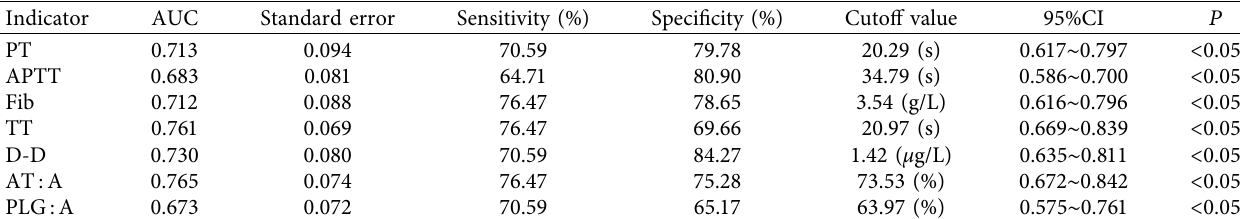
Table 4: Predictive effect of coagulation and fibrinolysis indexes on patient